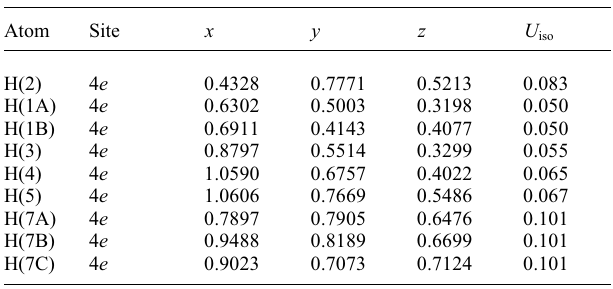
Table 3. Atomic coordinates and displacement parameters (in Å 2 ) .